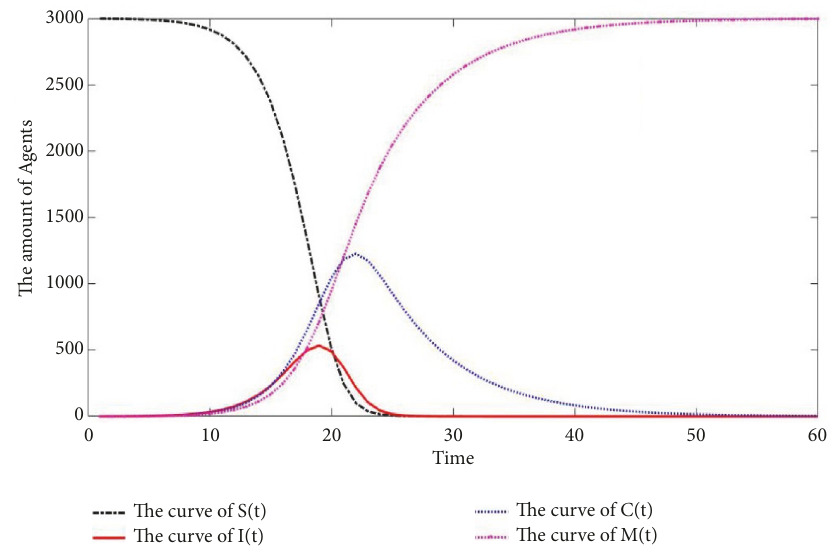
Figure 4: The evolutionary characteristics of risk contagion after increasing 𝑥 2 (Case 3).